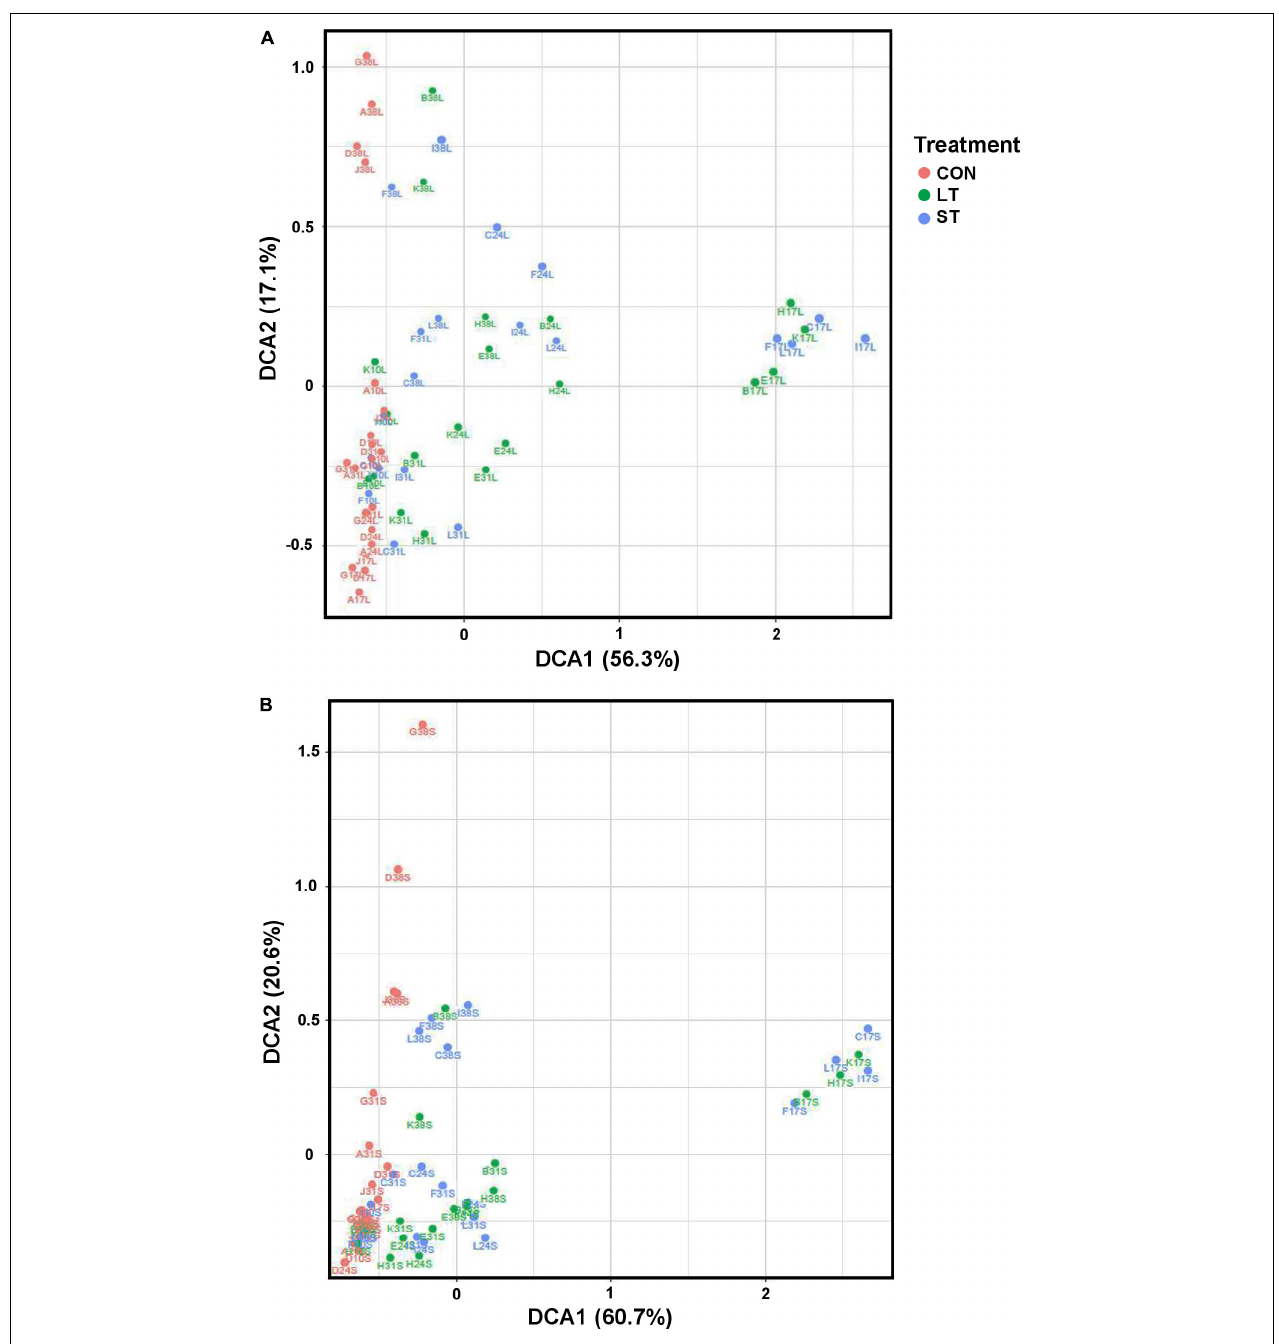
FIGURE 4 | The beta-diversity of Archaea is indicated by Detrending Correspondence Analysis (DCA) based on the UniFrac distances. Treatment groups are distinguished by color: CON, red; LT, green; ST, blue. The labels represent the day (10, 17, 24, 31, and 38) and the name of the fermentation vessel (A–L). Panel (A) shows the LAM, and (B) shows the SAM archaeal